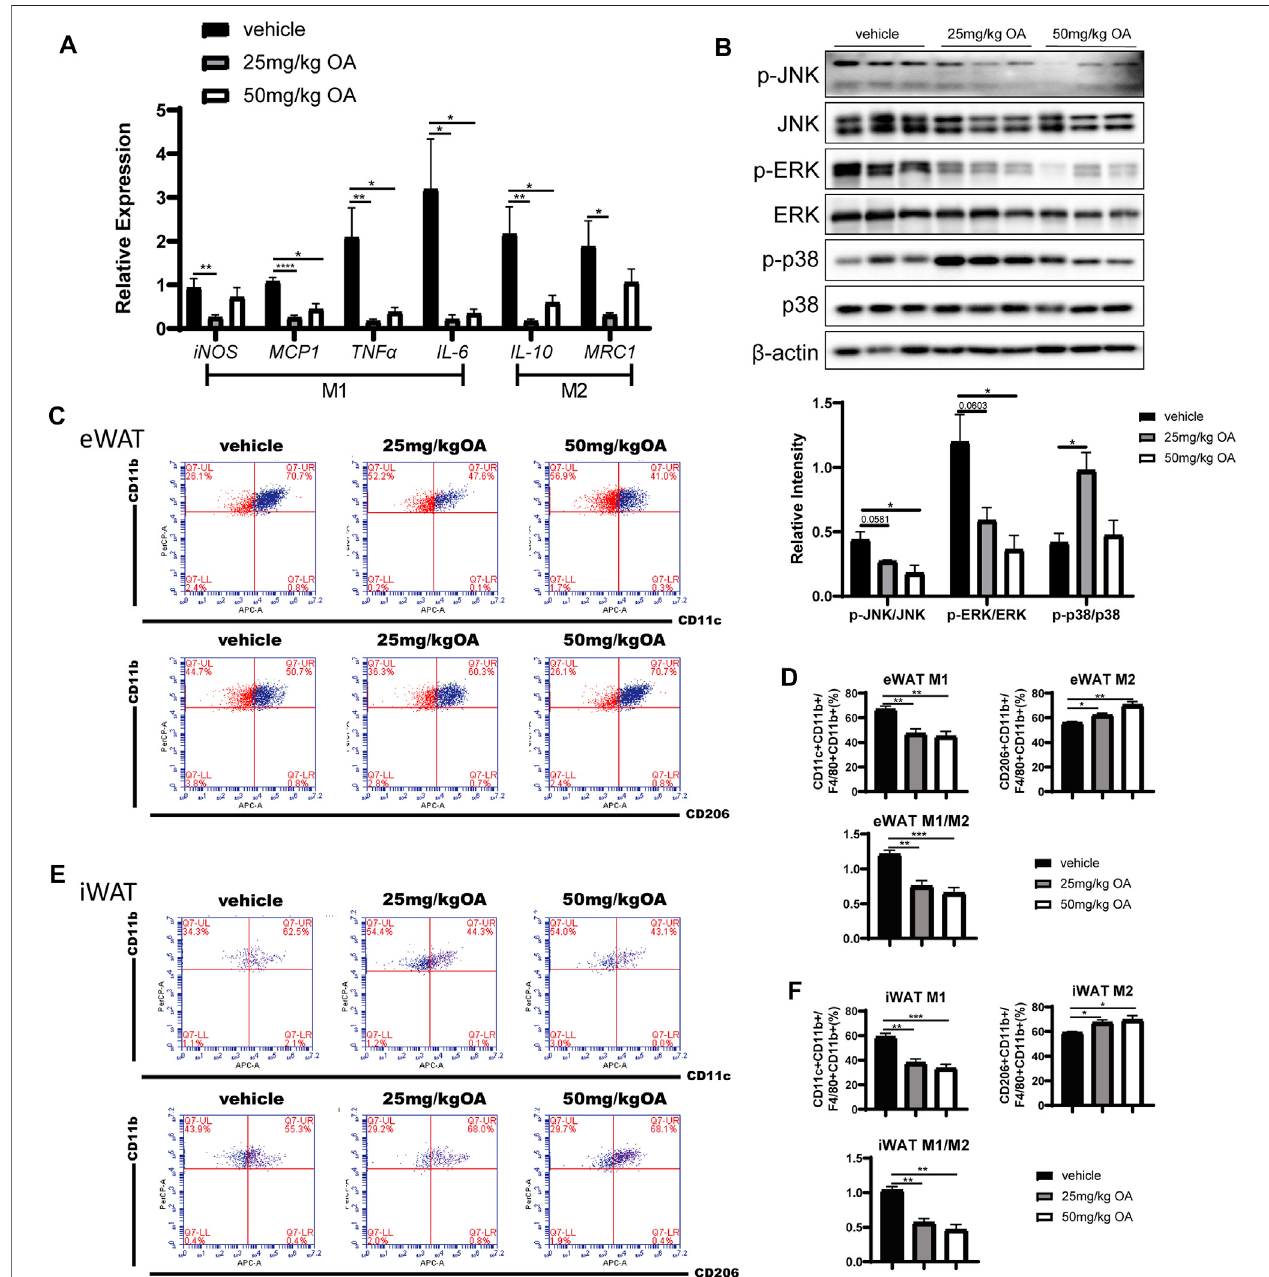
FIGURE 3 | OA decreases eWAT in fl ammation level and ratio of M1/M2 ATMs in DIO mice. (A) ATMs associated markers in eWAT ( n (cid:1) 5). (B) WB of phosphorylated p38 MAPK (p-p38 MAPK), phosphorylated JNK (p-JNK), phosphorylated ERK (p-ERK), and their total proteins in eWAT of mice. (C – F) FCM analysis of theSVFofeWATandiWATofmice( n (cid:1) 5). (C,E) RepresentativeplotsofFCManalysis:proportionofM1orM2macrophagestoATMs. (D,F) StatisticsofFCManalysis. Data are percentages of M1 ATMs, percentages of M2 ATMs, and M1/M2 ratios. * p < 0.05, ** p < 0.01, *** p < 0.001, **** p < 0.0001.